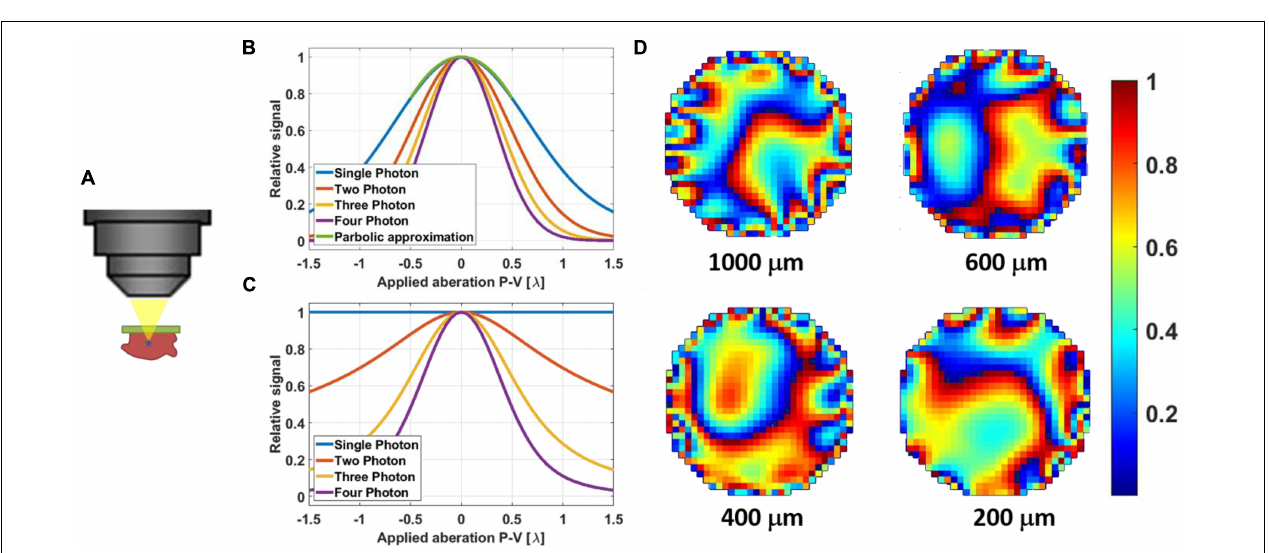
FIGURE 2 | (A) Illustration of a non-linear guide star in 3PM generated even in a thick sample. (B) Simulation results of signal degradation of a fluorescent bead (point source) due to applied aberration (astigmatism). The parabolic approximation for +/– λ is suitable even for single-photon excitation. (C) Simulation results of signal degradation of fluorescent dye pool (thick sample) due to applied aberration (astigmatism). Here the signal from single-photon excitation remains constant since the volumetric integral remains the same. Two-photon excited signal does degrade, but at a slower rate than those of three- and four-photon excitation. (D) Example phase maps of mouse brain in vivo as they were applied with the SLM for different correction depths at 200 µ m, 400, 600, and 1000 µ m. The phases are 2 π wrapped, and the color bar scale is for λ = 1.3 µ